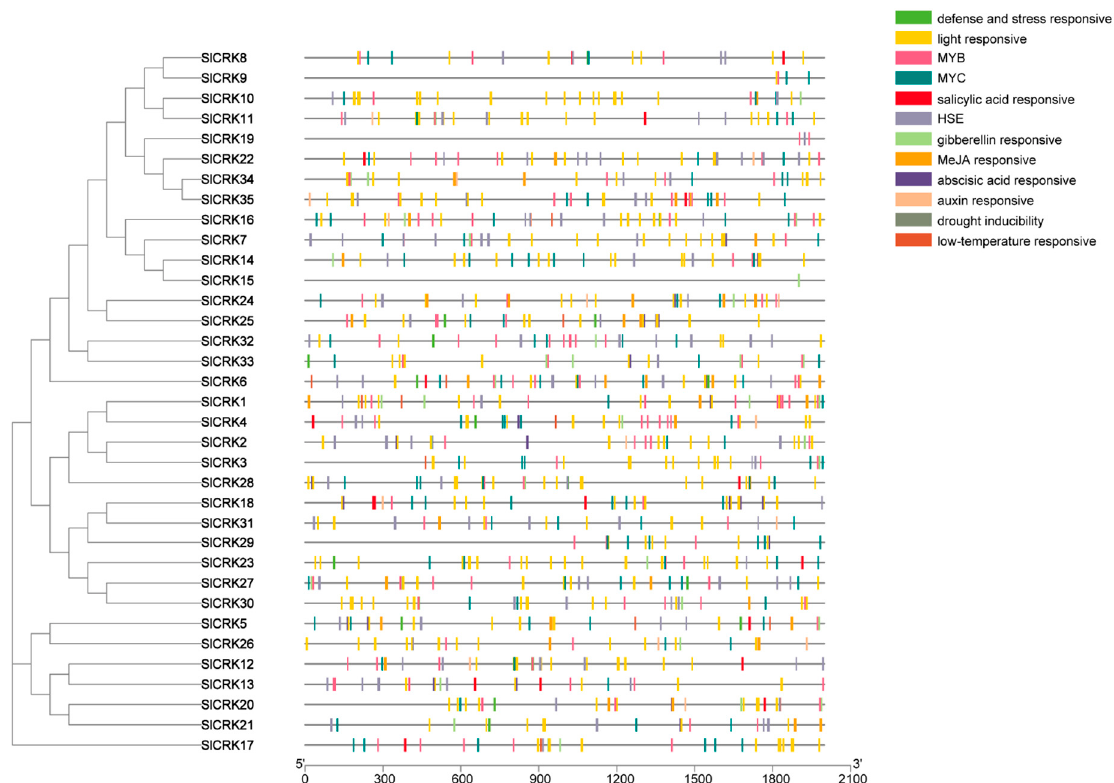
Figure 3. Cis-regulatory elements in SlCRK gene promoter regions, containing the upstream 2 kb region of SlCRK coding sequence.